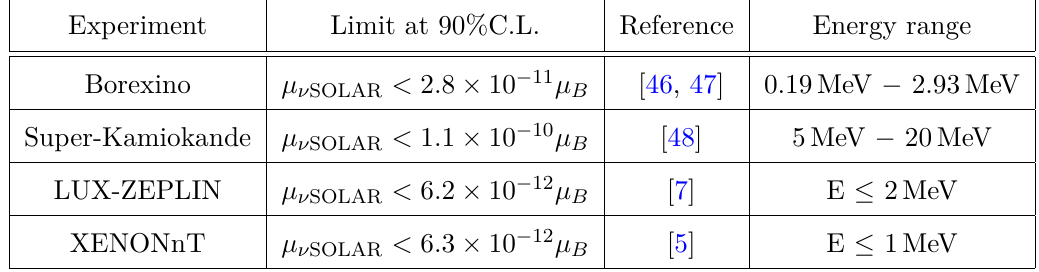
Table 4 . Limits on the effective neutrino magnetic moment from elastic scattering of solar neutrinos on